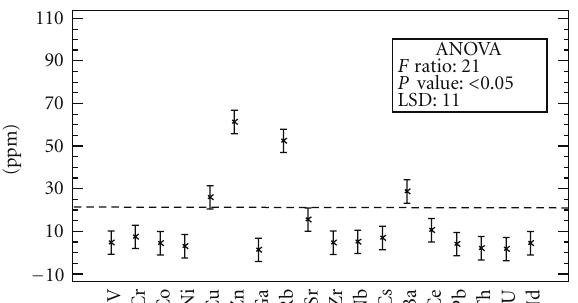
Figure 3: Mean value of each trace element for each of the three lifestyles studied (average over the seven species in each group) following the sequence ectomycorrhizae, saprobes, and epiphytic (from left to right in each element box).